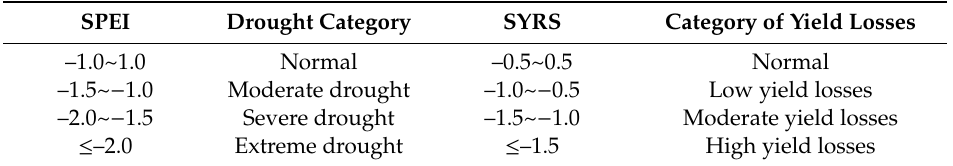
Table 1. Drought categories based on the Standard Precipitation Evapotranspiration Index (SPEI) and categories of yield losses based on the